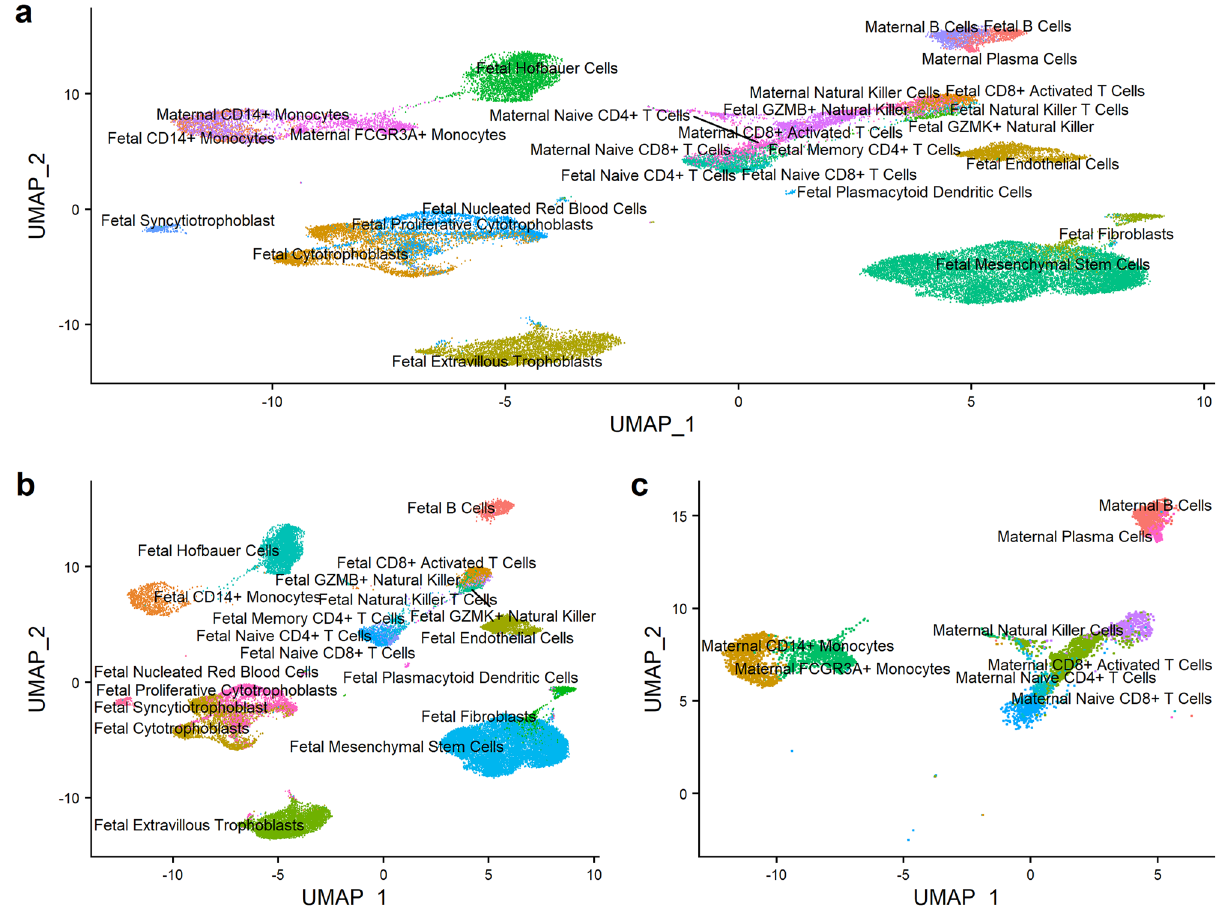
Fig. 1 Integrated single-cell gene expression map of healthy placental villous tissue. a Uniform Manifold Approximation and Projection (UMAP) plot of all cells ( n = 40,494), with each cell colored by cell type cluster. b UMAP plot of fetal cells only ( n = 34,165), with each cell colored by cell type cluster. c UMAP plot of maternal cells only ( n = 6329), with each cell colored by cell type